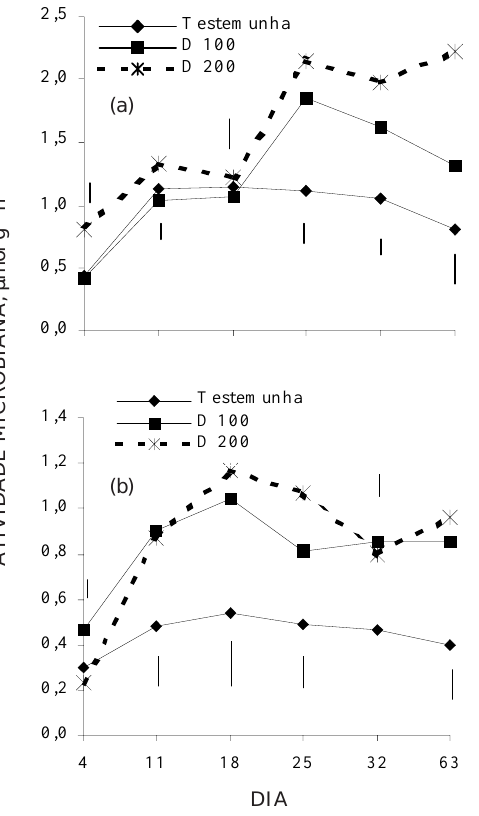
Figura 2. Atividade microbiana nos solos (a) Terra Roxa Estruturada e (b) Latossolo Vermelho- Amarelo, tratados com diuron e 100 e 200 m 3 ha -1 de vinhaça. (D 100 = diuron + 100 m 3 ha -1 de vinhaça, D 200 = diuron + 200 m 3 ha -1 de vinhaça). As barras indicam a diferença mínima significativa (DMS) pelo teste t a 0,05 de